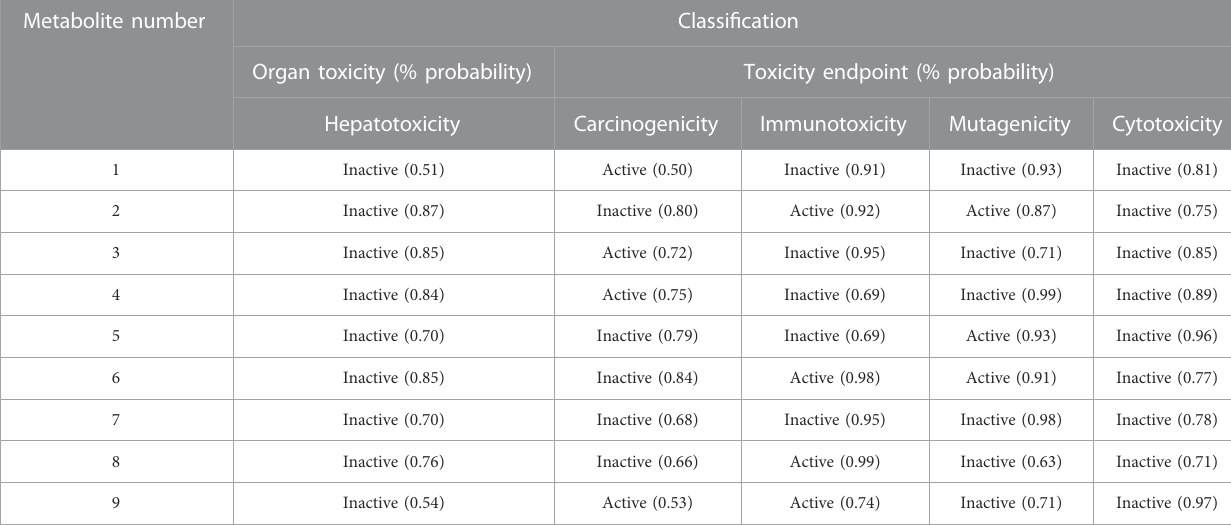
TABLE 5 Organ and endpoint toxicity predictions using the ProTox-II web